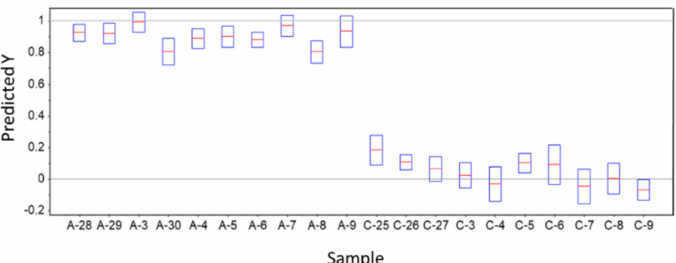
Figure 5. PLS-DA model predicted Y values for ADHD (A) and Control (C) test samples. The predicted values are indicated by the horizontal red lines and the deviations by the blue boxes. In the model, samples belonging to the Control Group define a class with reference Y value equal to 0, and those belonging to ADHD patients define a class with reference Y value equal to 1.